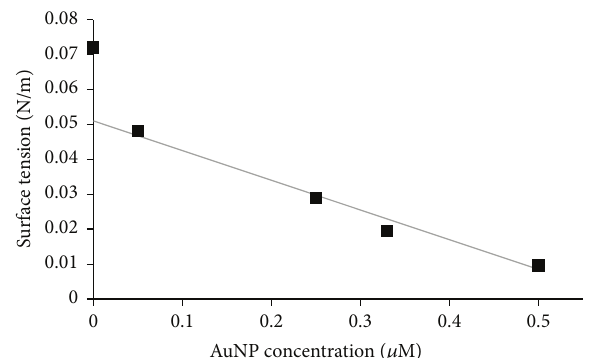
Figure 6: Liquid-vapor surface tension versus AuNP concentration. Surface energy decreases linearly with concentration as nanoparti- cles accumulate at the liquid-vapor interface.